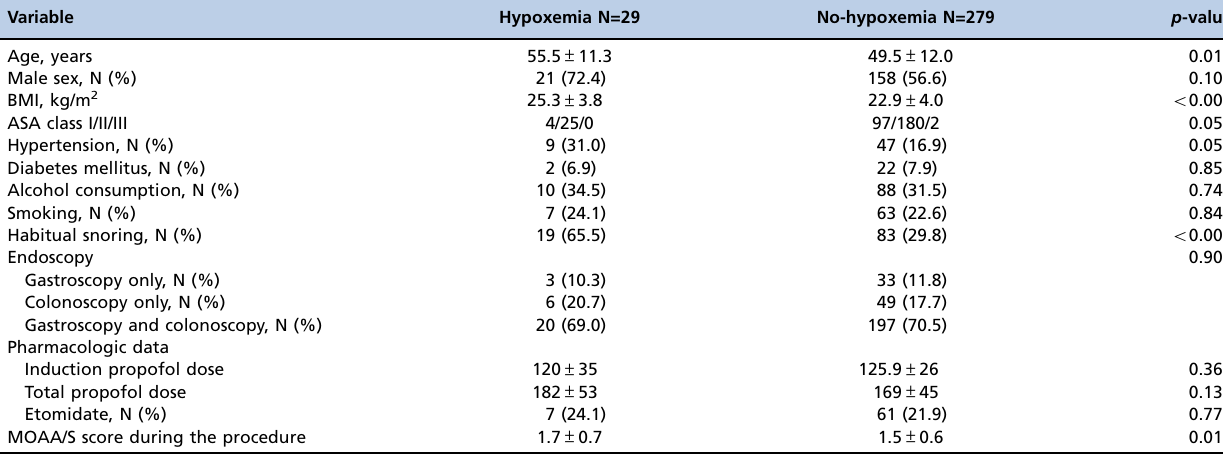
Table 1 - Baseline characteristics and clinical outcomes of 308 patients in the two study groups.